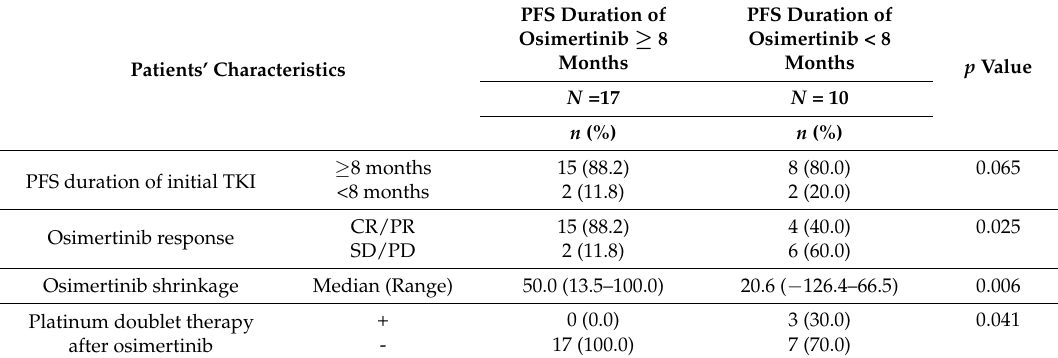
Table 3. Patients’ characteristics of clinical course classified progression-free survival duration of osimertinib.